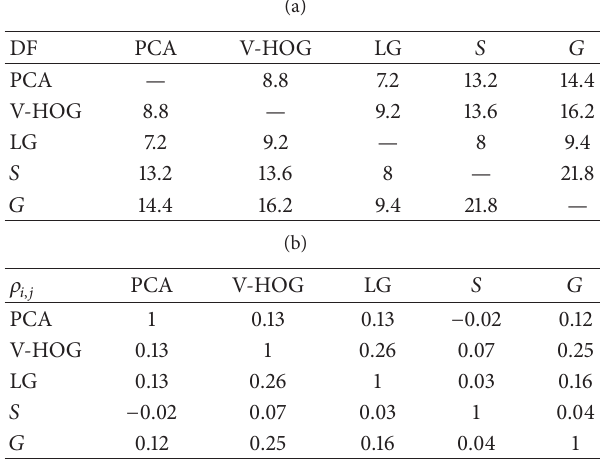
Table 9: Performance of the proposed ensembles for the left close/ middle region.